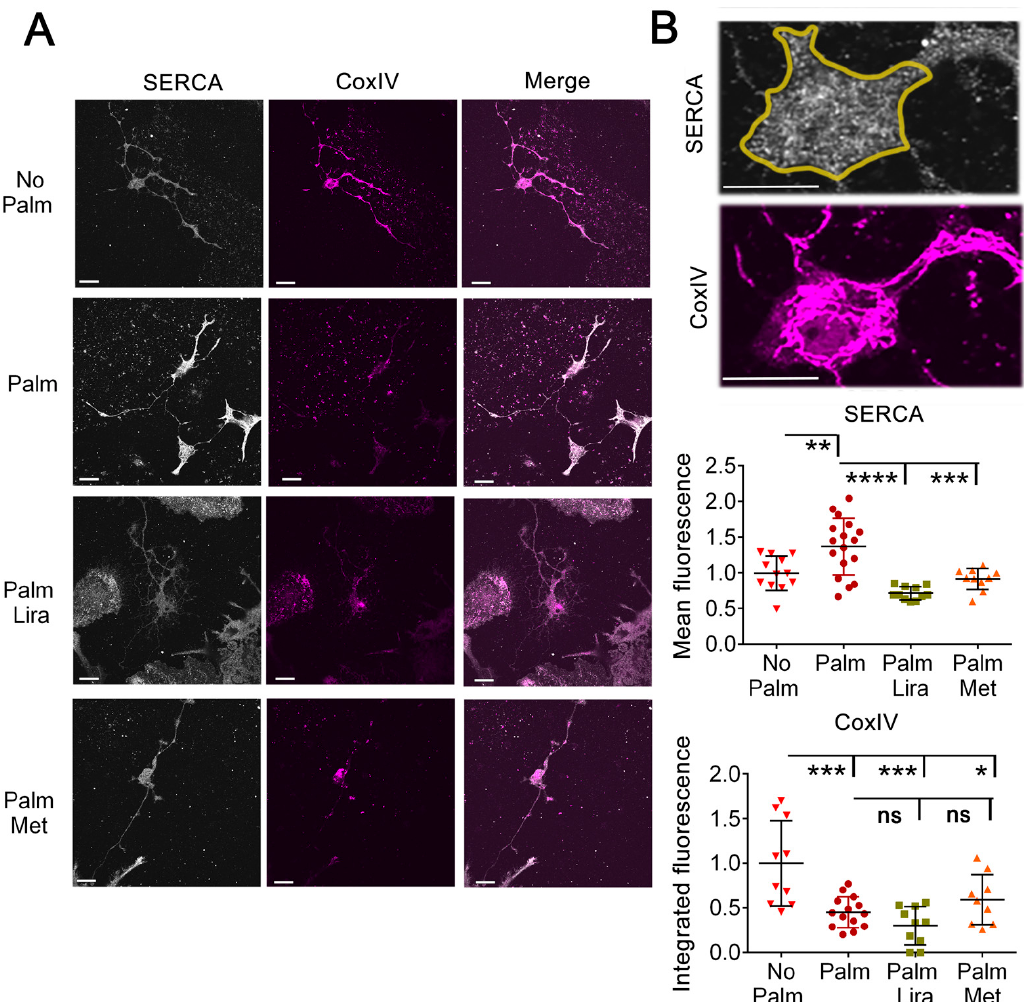
Figure 5. Exposure to palmitate increases expression of SERCA2 and lowers abundance of CoxIV in hypothalamic neurons exposed to elevated palmitate. Metformin and liraglutide normalize abundance of SERCA2, while CoxIV remains decreased. ( A ) Hypothalamic neurons treated as in Figure 4A were immunostained with anti-SERCA2 (white fluorescence) and anti-CoxIV (magenta fluorescence) antibodies, and imaged by confocal fluorescence microscopy. Bars, 5 µm; ( B ) Mean fluorescence pixel density of KDEL and integrated fluorescence density per cell of CoxIV in ROIs that include the cytoplasm (a representative ROI is the area encircled by yellow line in the panel above the graph showing at a higher magnification KDEL and CoxIV immunostaining at the cell body) using ImageJ software. Bars, 5 µm. Pixel fluorescence density of the ROI is derived from neurons extending processes (n ≥ 9 per group, each graph symbol represents one cell; * p < 0.05; ** p < 0.01; *** p < 0.001; **** p < 0.0001, ns, not significant). Decreased abundance of CoxIV and of other components of the ETC are features of neurodegenerative diseases [45]. We have found that, in the hypothalamus of mice exposed to a high-fat diet, there is loss of cytochrome oxidase IV (CoxIV), the terminal